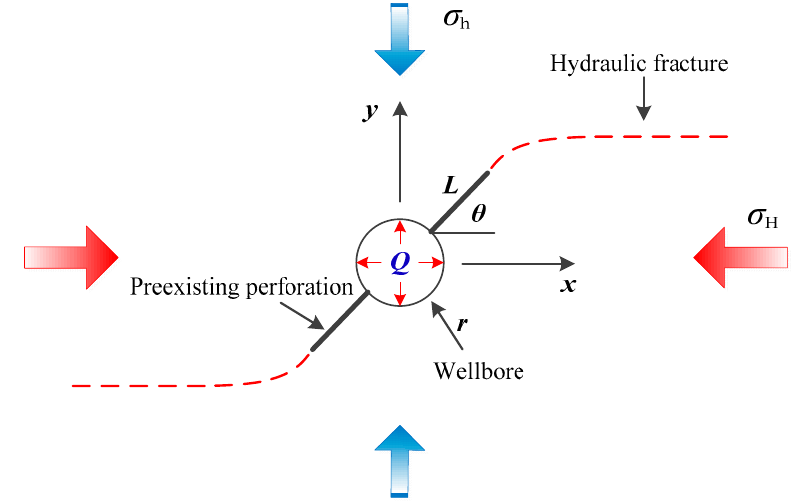
Figure 1. Hydraulic fractures initiate from two symmetrically disposed preexisting perforations.